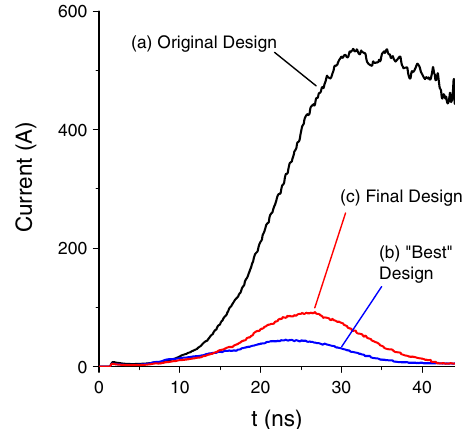
FIG. 7. (Color) The simulated electron current passing through the inner-MITL B -dot probe apertures for the (a) original design (black curve), (b) the best design (blue curve), and (c) the final design (red curve) as a function of